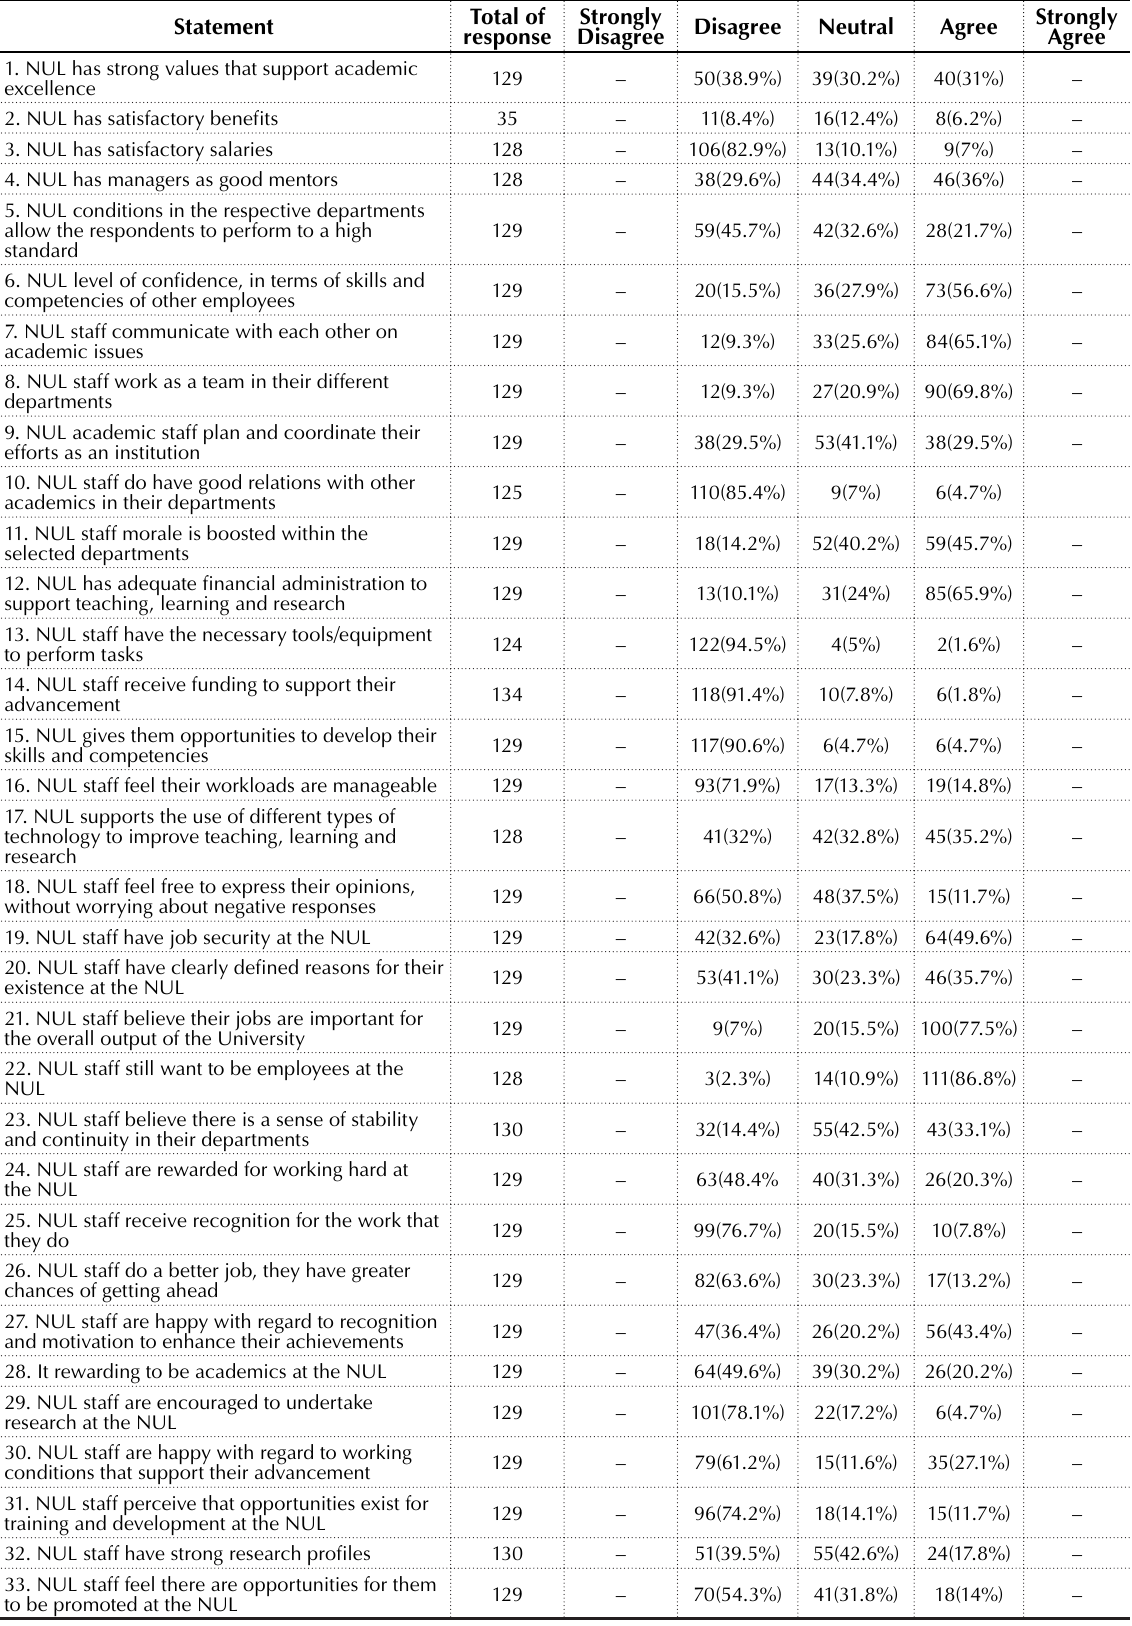
Table 3. Findings of the